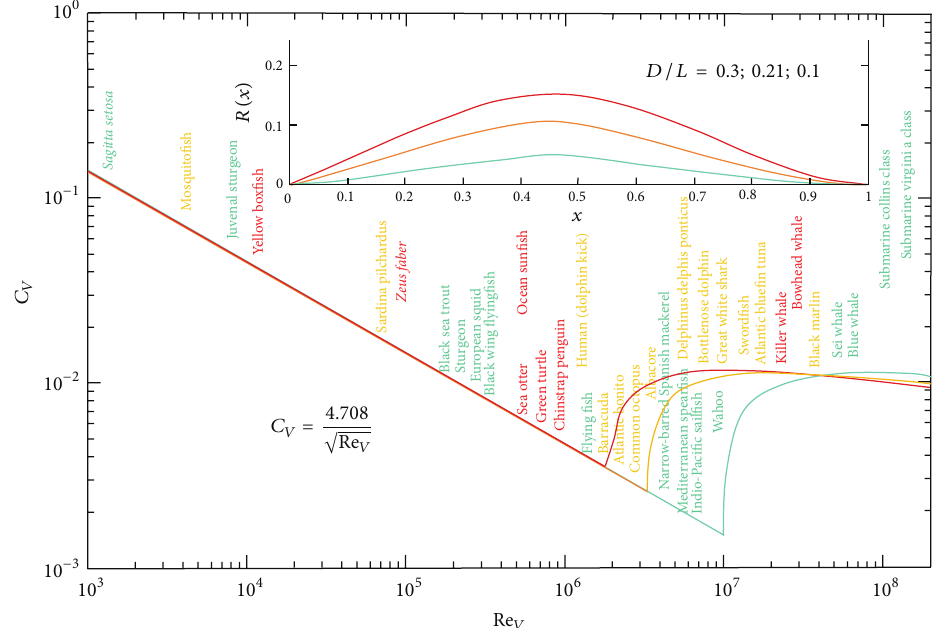
Figure 3: Minimal drag coefficients for different animals and vehicles. Typical shapes at different values of the thickness ratio 𝐷/𝐿 .